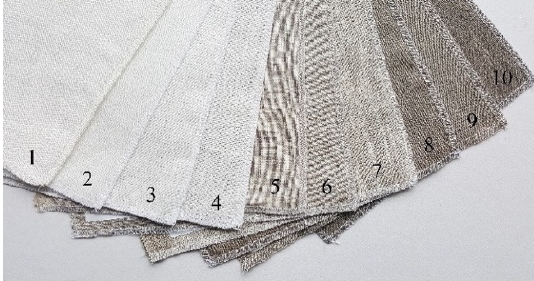
Figure 3. Linen fabrics selected for investigation.